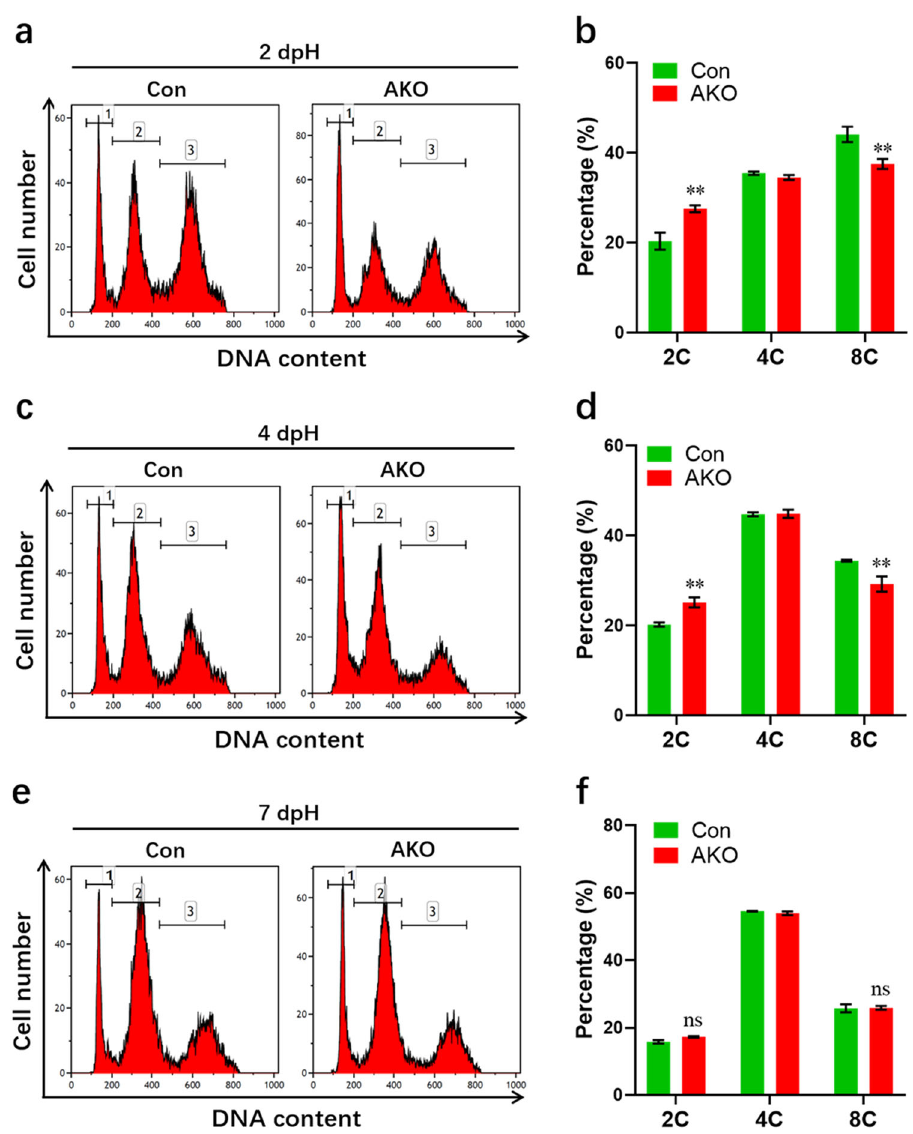
Fig. 4 Effects of constitutive loss of FoxO3 on hepatocyte ploidy during liver regeneration in adult mice. Primary hepatocytes isolated from livers at 2 ( a , b ), 4 ( c , d ), and 7 ( e , f ) dpH were subjected to ploidy contribution analysis using fl ow cytometry. Representative images ( a , c , and e ) and quanti fi cation ( b , d , and f ) of the ploidy contribution of hepatocytes isolated from Con and AKO mice are shown ( n = 3 mice per group). Peaks 1, 2 and 3 depicted, respectively, 2 C, 4 C, and 8 C cells. All data are presented as the mean ± SEM. ** p < 0.01 versus control mice (two-way ANOVA